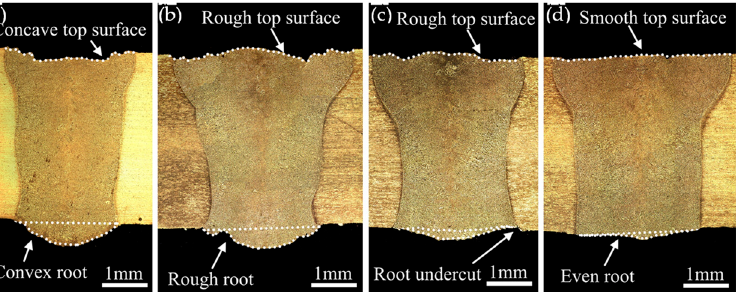
Figure 2. Weld seam and corresponding cross-section morphologies of the joint welding of 4 mm thick AA6061 plates: ( a ) without oscillation; ( b ) transverse oscillation; ( c ) longitudinal oscillation; ( d ) circular oscillation. Reproduced with permission from Elsevier [99].